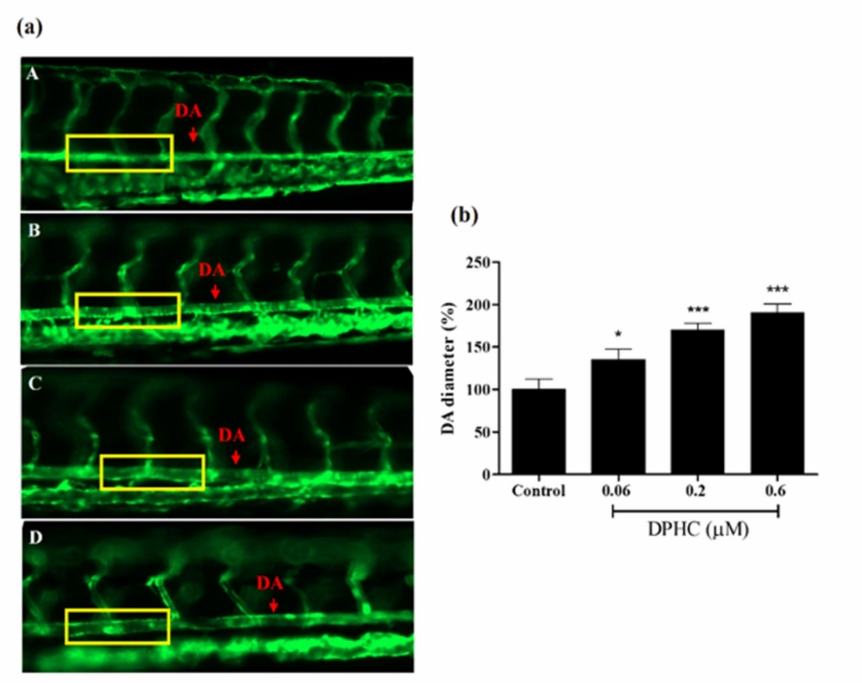
Figure 7. Vasodilation observed by changes in the vessel diameter in a Tg(flk:EGFP) transgenic zebrafish model. ( a ) Images of the vessel were captured using a fluorescence microscope (20 × ). (A–D) Vasodilation observed by treatment with DPHC at 6 dpf. A: 0 µ M of DPHC (Control); B: 0.06 µ M of DPHC; C: 0.2 µ M of DPHC; D: 0.6 µ M of DPHC. ( b ) Measurement of the DA diameter. Each column and bar represents the mean ± standard deviation (S.D.), n = 8 per group. * p < 0.05, *** p < 0.001, significant difference compared to the control group. DPHC: diphlorethohydroxycarmalol; DA: dorsal